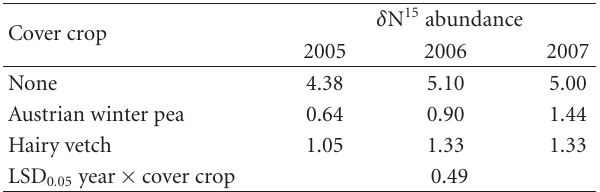
Table 2: δ N 15 abundance in plant residues before desiccation in